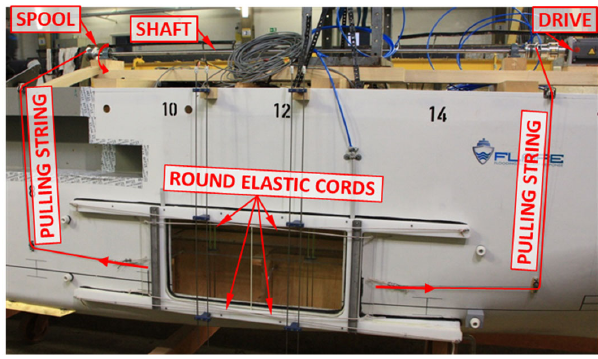
Figure A1. Damage opening mechanism for Damage Case 2.